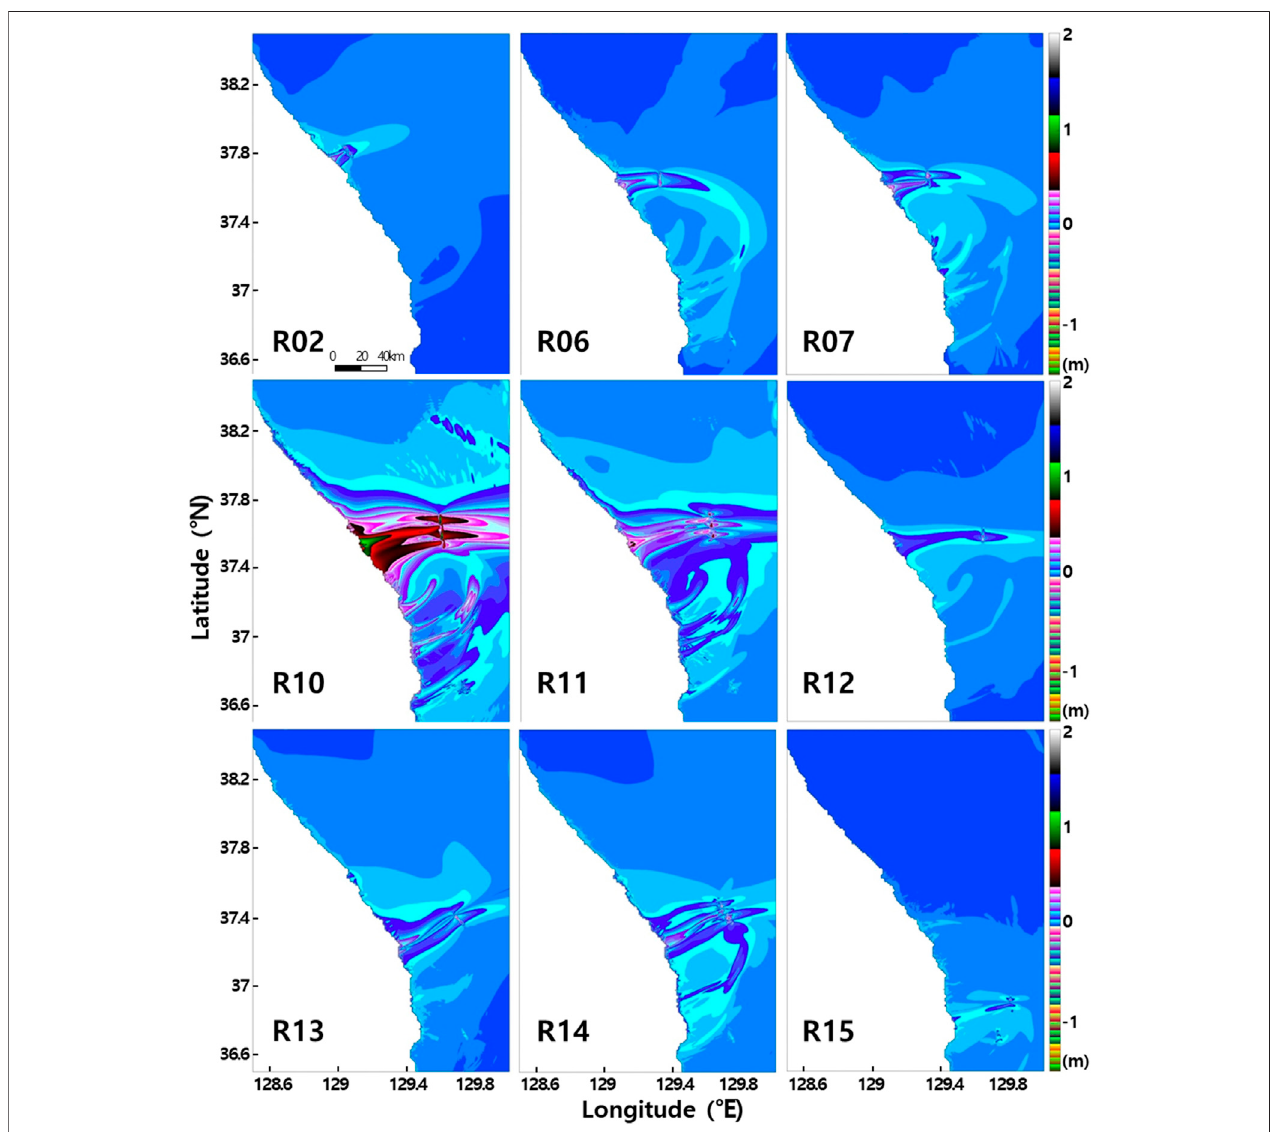
FIGURE 6 | Maximum wave height of tsunamis in the East Sea, estimated from numerical modeling for different scenarios (fault zones; Combination A).